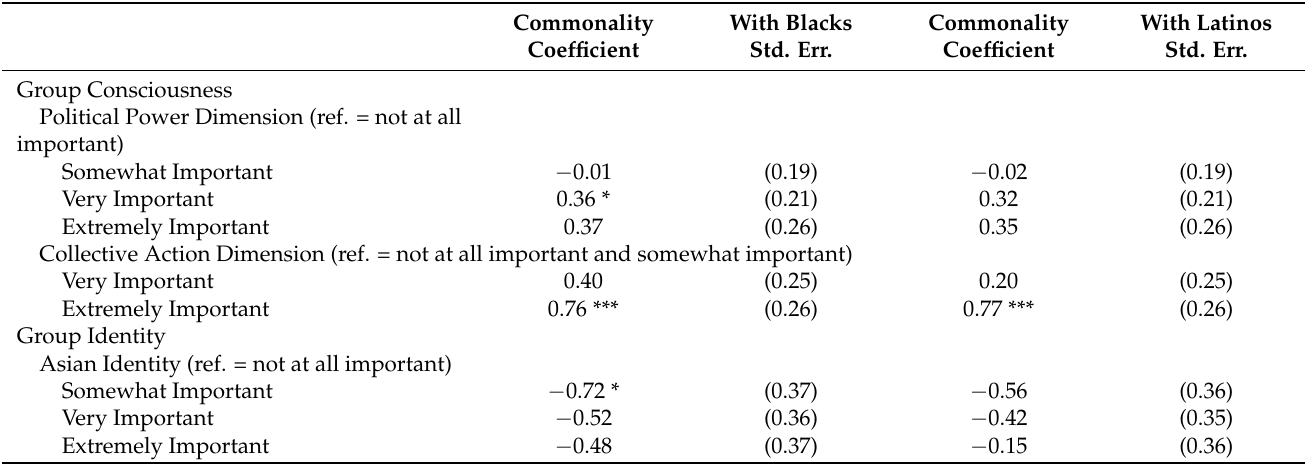
Table 3. Ordered logistics regression coefficient results of Asian American interracial commonality ( N = 735). *** p < 0.01, ** p < 0.05, * p <